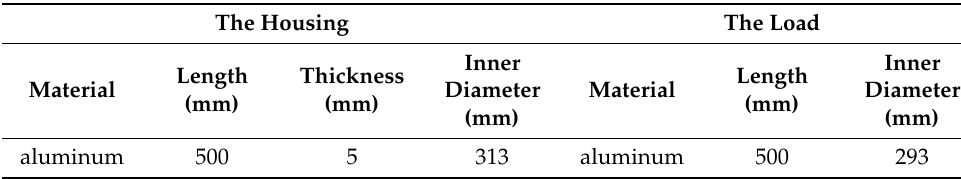
Table 1. The structural parameters of the test system.